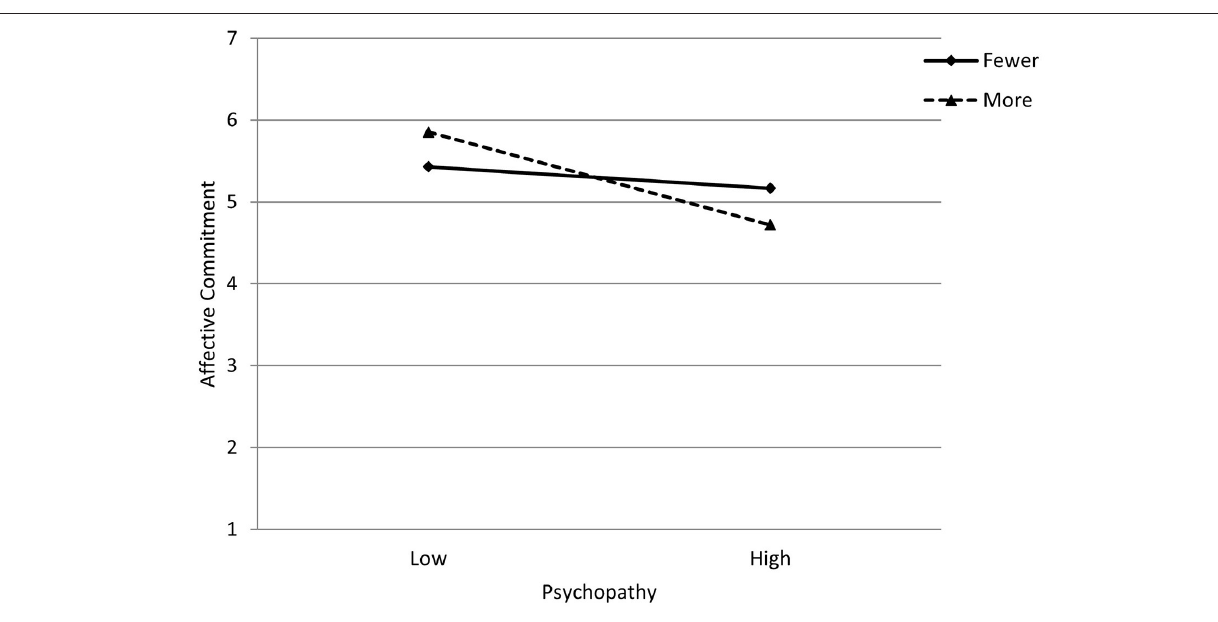
time out of work (e.g., career interruption) or in precarious (i.e., part-time or casual) employment. It may be that subclinical psychopathy is not associated with this